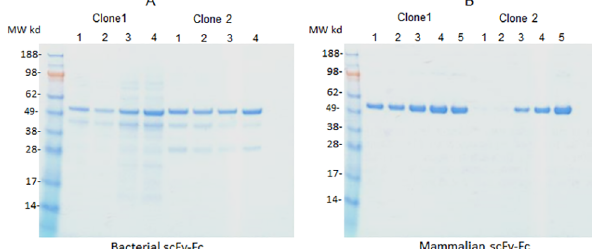
Fig 3. SDS-PAGE analysis of pSplice vectors in E . coli and 293F cells. (A) Non reducing SDS-PAGE of scFv.Fc of clone 1 and 2 expressed from pSplice version 2, 3, 4 and 5 vectors in E . coli (lanes 1, 2, 3 and 4, respectively). (B) Non reducing SDS-PAGE of scFv.Fc of clone 1 and 2 expressed from pSplice version 2, 3, 4 and 5 vectors and the parental pOEscFv.Fc (lanes 1, 2, 3, 4 and 5, respectively) in 293F cells. Mammalian expression vector, pOEscFv.Fc is used to compare how the dual expressing pSplice vectors perform in comparison to pOEscFv.Fc vector.